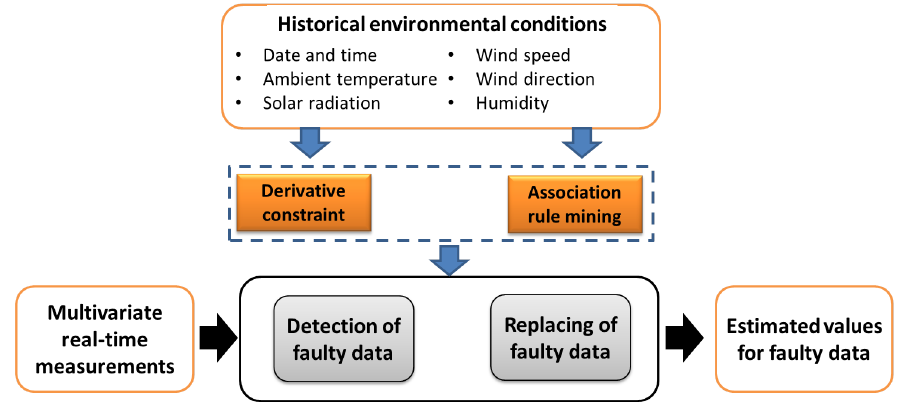
Figure 5. System architecture of the proposed